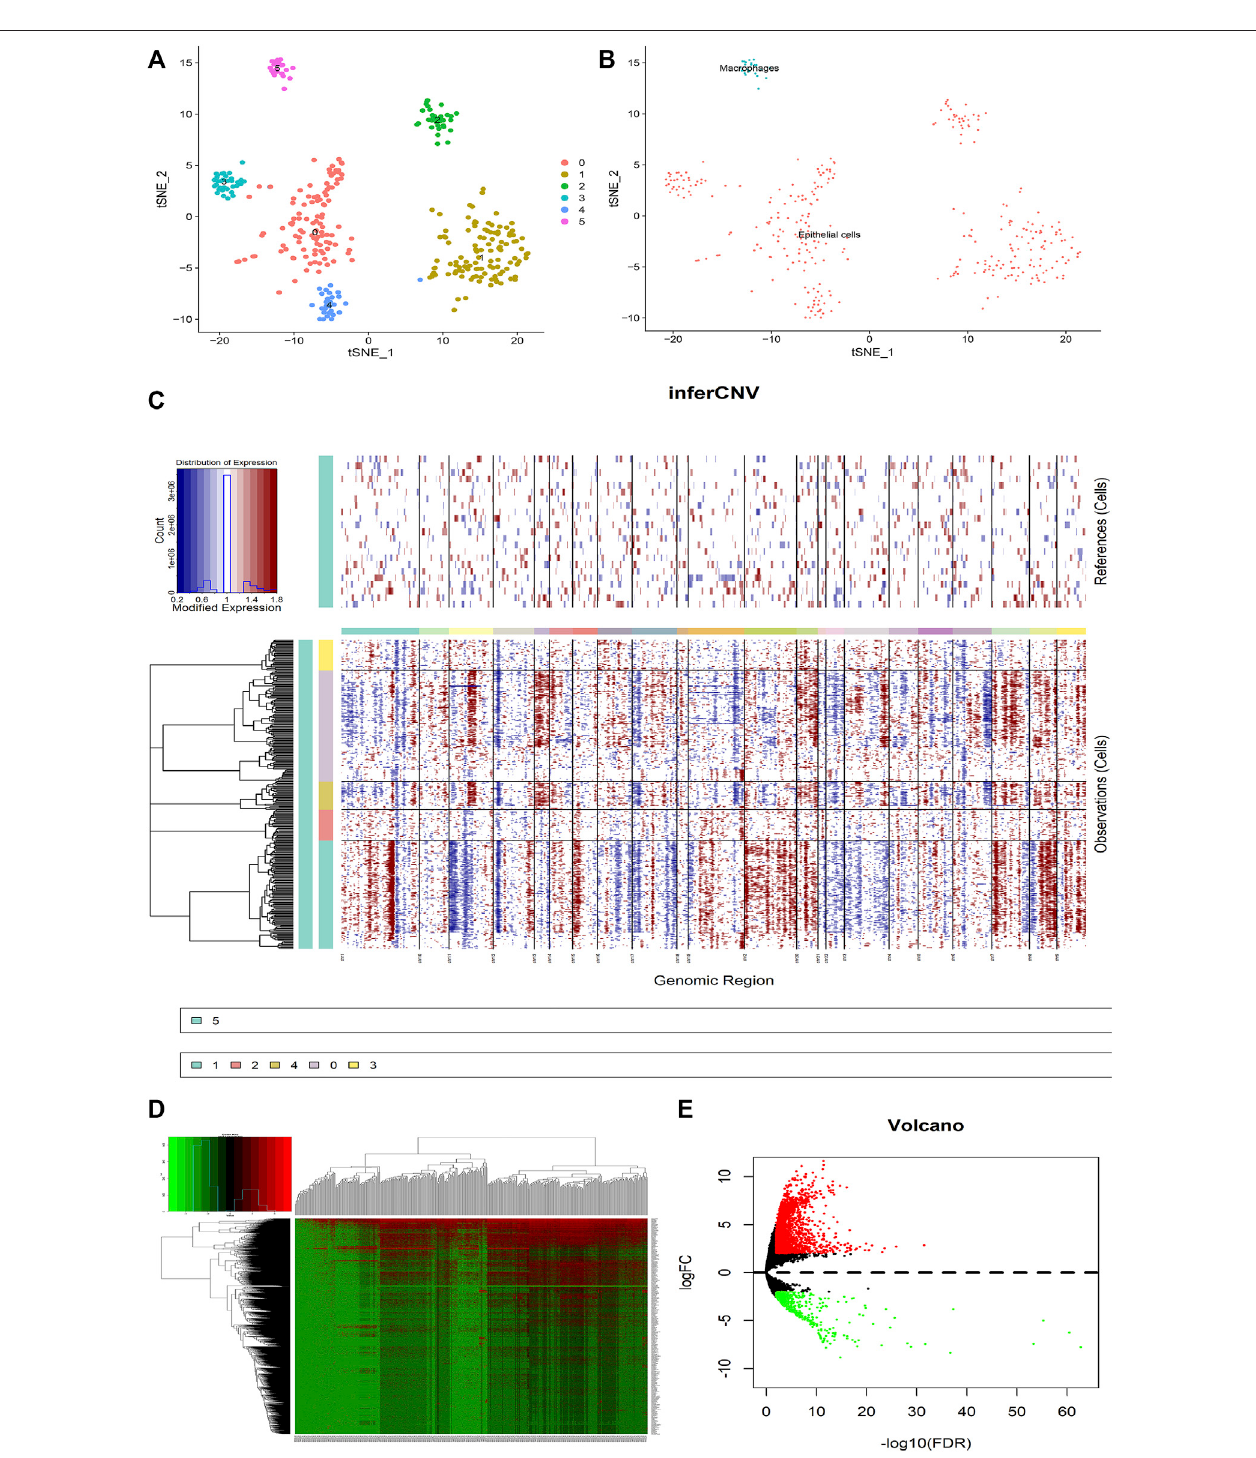
FIGURE 2 | Analysis of the difference between malignant cells and normal epithelial cells in GC tumors. (A) The tumor cells are clustered into six clusters including 0 – 5, clusters 0 – 4 are annotated as epithelial cells, and cluster 5 is annotated as macrophages. (B) The cells are divided into epithelial cells and macrophages. (C) CNV heat map of other epithelial cells with cluster 5 macrophages as a control. (D,E) Heat map and volcano map for differential analysis. Red represents upregulation and green downregulation, |logFC| > 2, p < 0.05.